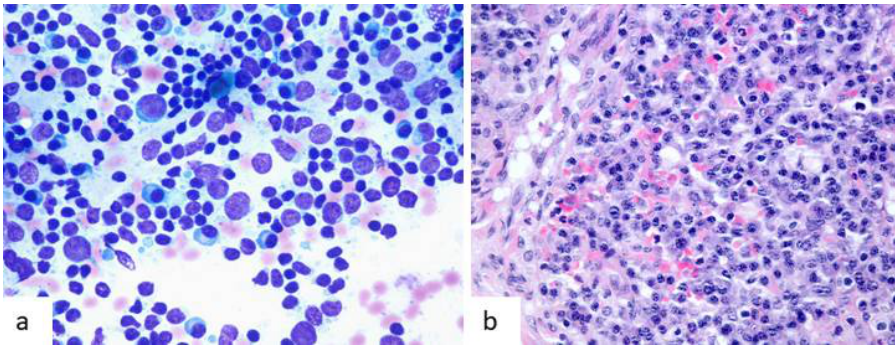
Figure 5. Cytological images in a case of plasma cell Castleman disease (PC-CD). ( a ) Smears show a reactive image with lymphoid polymorphic cells accompanied by numerous mature plasma cells (Diff-Quik, ×400). ( b ) Lymph node histology reveals areas of sheet-like distribution of plasma cells (HE, ×400).